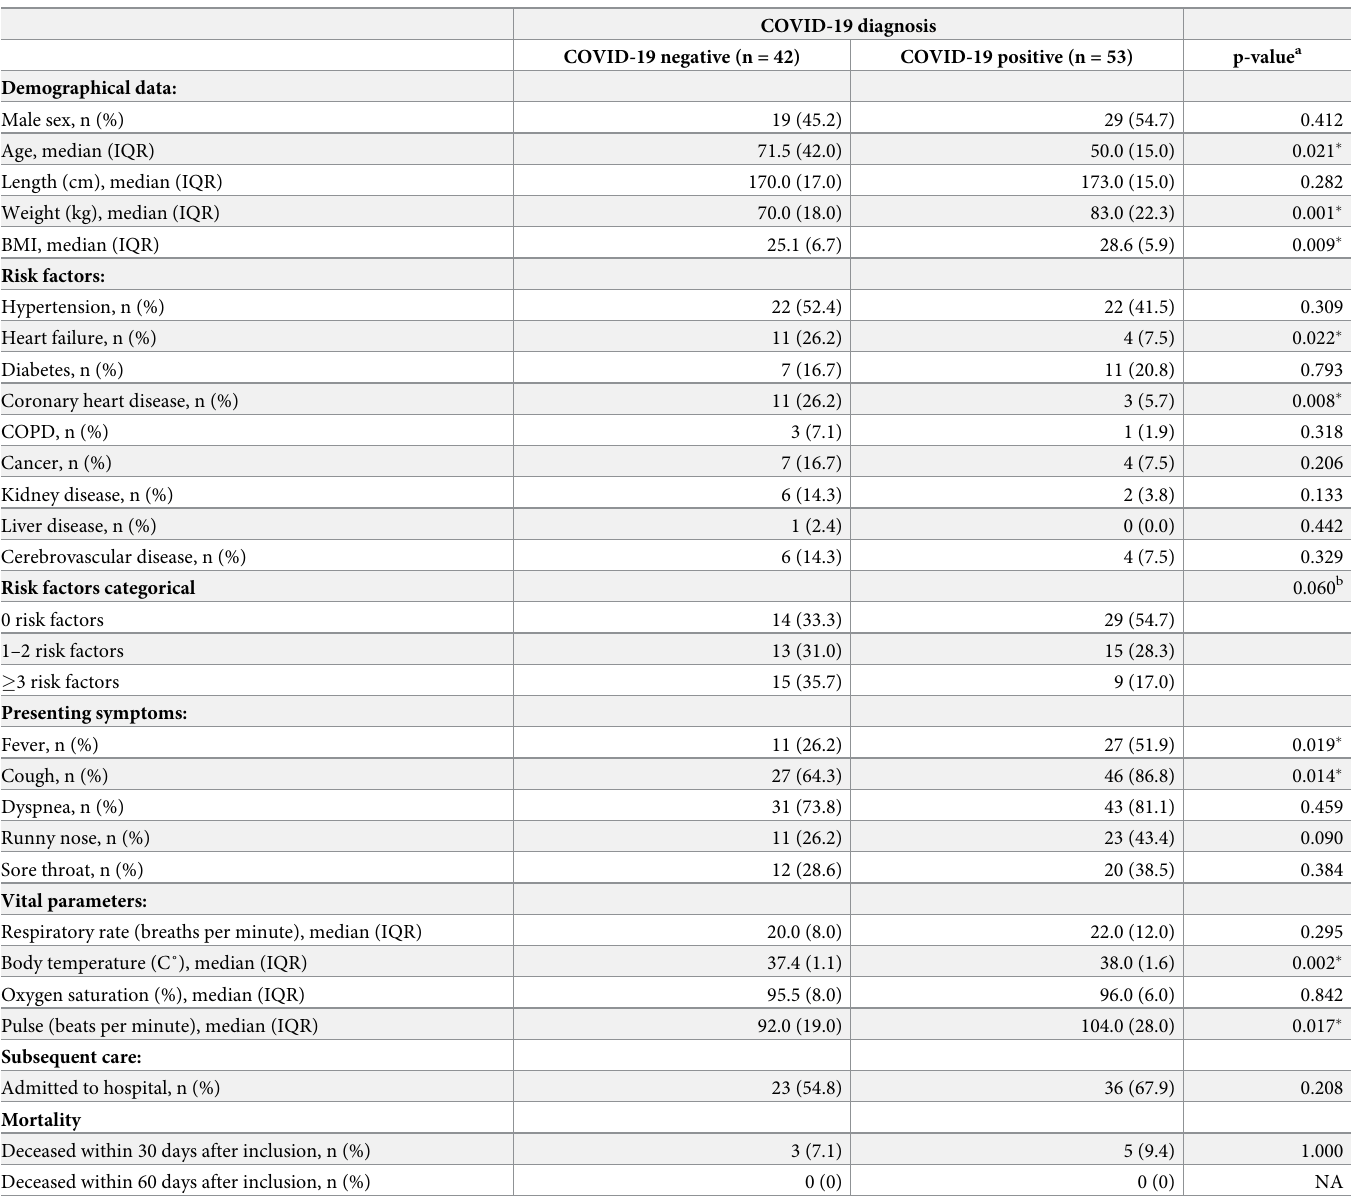
Table 1. Patient